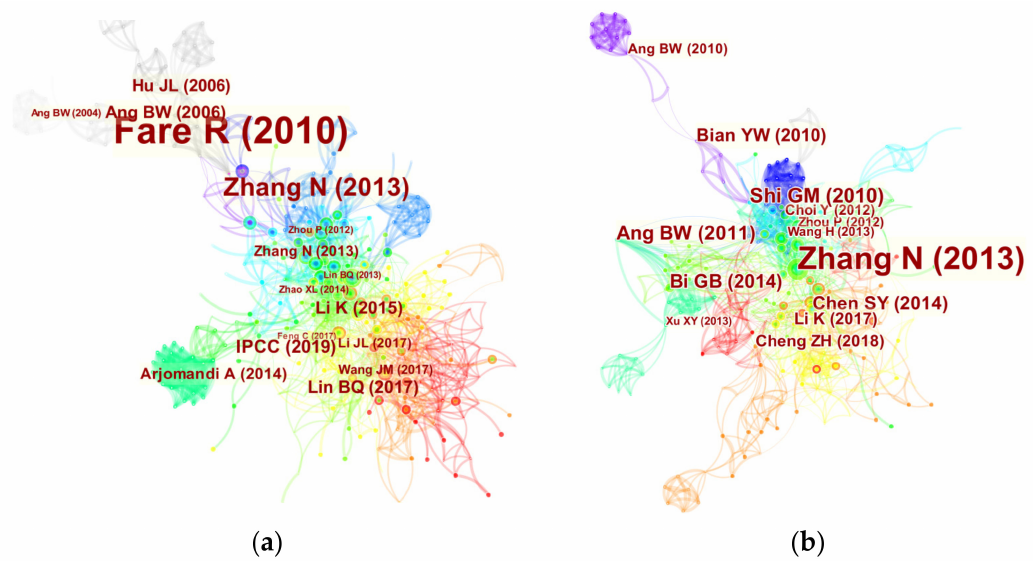
Figure 3. Map of authors in the TFEE ( a ) and TFCE ( b ) cited literature.